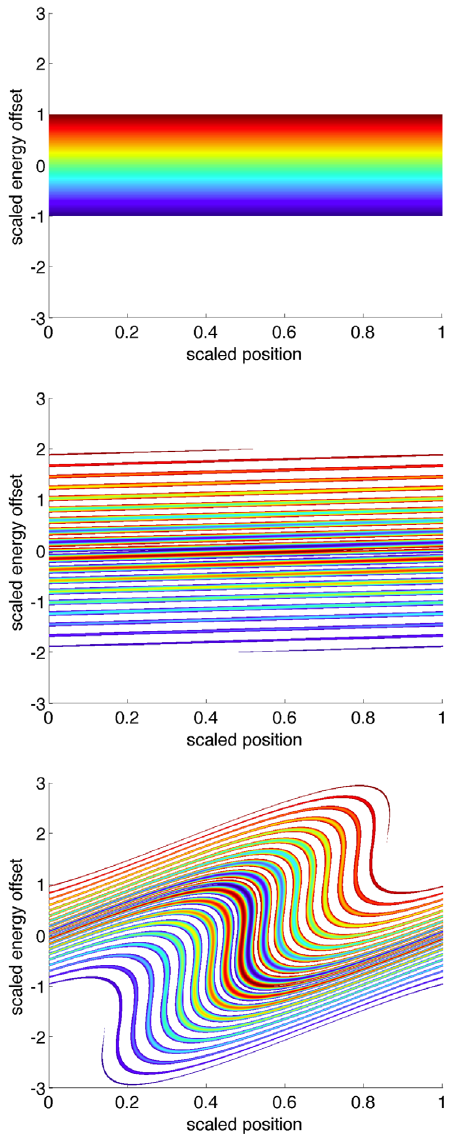
FIG. 1. Phase space distributions throughout the EEHG manipulations. The original beam (top) was a flat-top in energy between − 1 and þ 1 in scaled co-ordinates. After the first modulation and chicane the beam is overbunched (middle). The final distribution (bottom) has maximum bunching at the 25th harmonic, but the typical spacing between adjacent bunches is close to the 27th harmonic. Incoherent radiation and scattering have been ignored in these